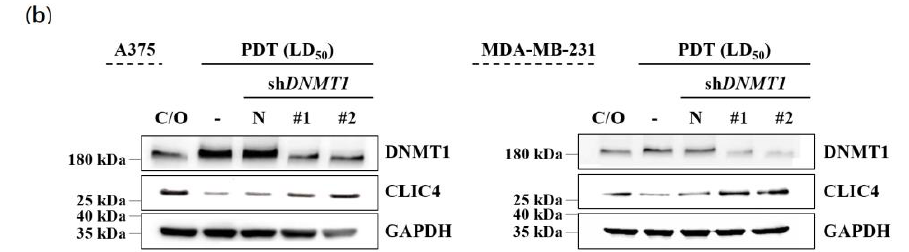
Figure 4. Down-regulation of DNMT1 restored the suppressed expression of CLIC4 in PDT-treated cells. A375 (left panel) and MDA-MB-231 (right panel) cells were transfected with either the shDNMT1 (denoted as shDNMT1 #1 and #2) or an empty shRNA vector (pLKO.1, as negative control). ( a ) Total mRNA and ( b ) protein samples were isolated from cells 24 h after ALA-PDT. The light dose for A375 and MDA-MB-231 cells is 2 J/cm 2 and 4 J/cm 2 , respectively. The relative mRNA expression level of each gene was measured by RT-PCR and normalized to β -actin. The protein expression levels of DNMT1 and CLIC4 were analyzed by Western blotting, and GAPDH was used as an internal control. The control group was cells only treated with ALA w/o light irradiation. For electrophoretic gels, the same volume of each PCR product was loaded, and band blots for each gene were cropped from different gels. For immunoblots, equal volume of each sample with the same concentration was loaded into each well, and the blots were cropped from different sections of the same gel. Data represent from three independent experiments. Each bar shown is the mean fold change relative to control ± SD. Results are considered to be statistically significant at ** p < 0.01.